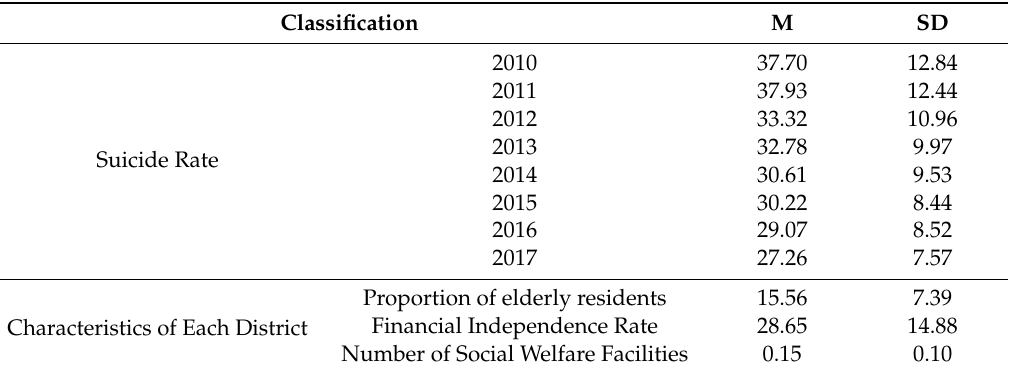
Table 1. Descriptive Statistics of Major Variables.